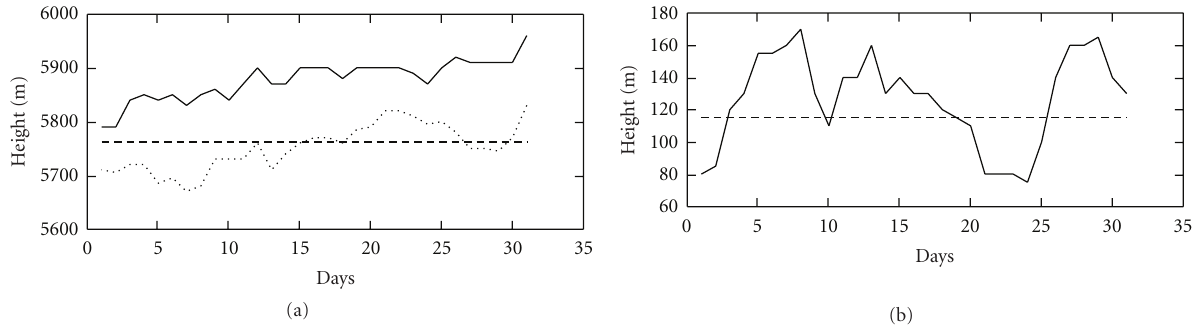
Figure 3: The block center region height (m) for July 2010 following [10] showing (a) the total height field (solid) and planetary-scale height (dots), and (b) synoptic-scale height (solid). The horizontal straight lines show the monthly mean, (a) planetary-scale, and (b) synoptic-scale